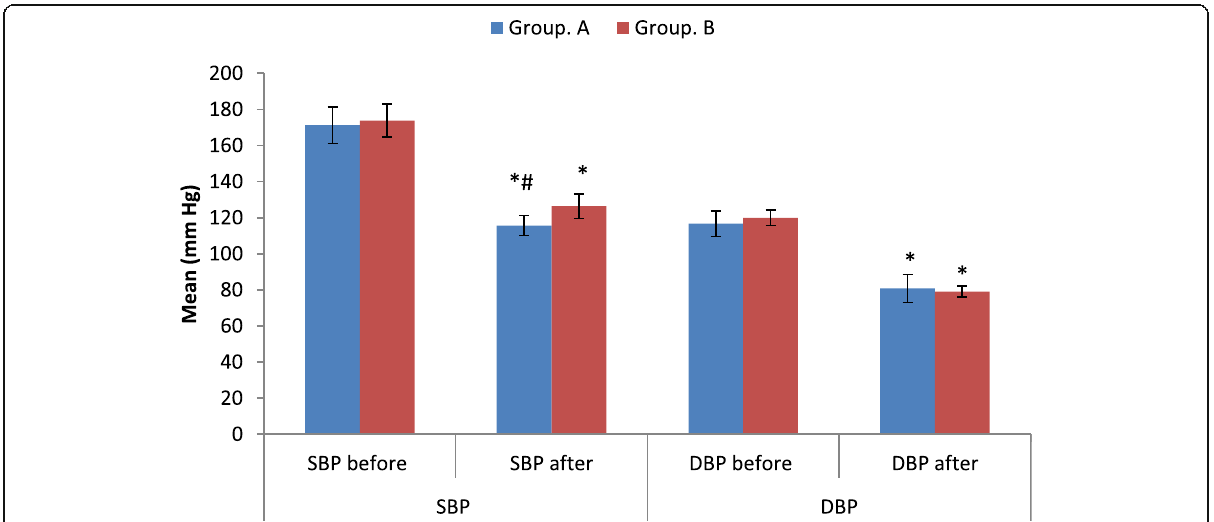
Fig. 1 Maternal systolic and diastolic blood pressure before and after treatment in both groups. *Significant decrease after in the two groups, # significant difference between the two groups after treatment